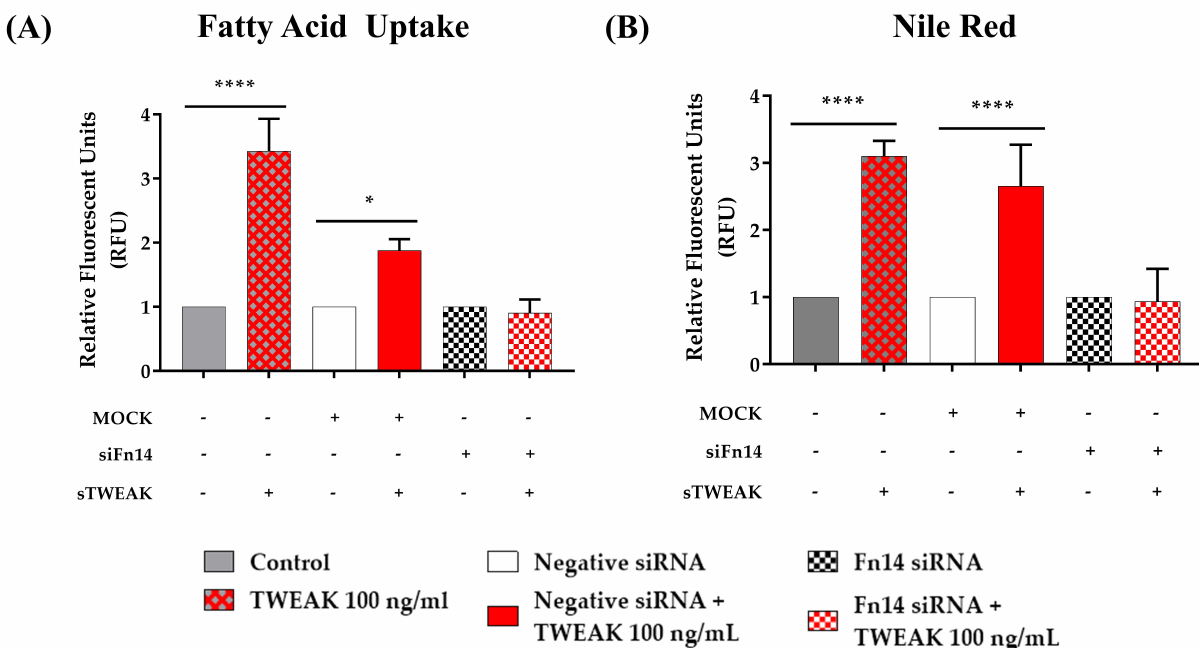
Figure 4. sTWEAK stimulation induces lipid uptake and accumulation in PC-3 cells. Cells were treated with 100 ng/mL TWEAK for 48 h. ( A ) Uptake of the fatty acid analog TF2-C12 was measured after 30 min. ( B ) Lipid accumulation was measured with Nile Red dye after 15 min of incubation. Fn14 was silenced in PC-3 cells using a Fn14 siRNA; a siRNA- negative sequence (MOCK) was used as a control. Data are expressed as mean ± SEM ( n = 4 experiments). Significant differences: * p < 0.05 and **** p < 0.0001. Abbreviations: sTWEAK, soluble TNF-like weak inducer of apoptosis; siFn14, Fn14 small interfering